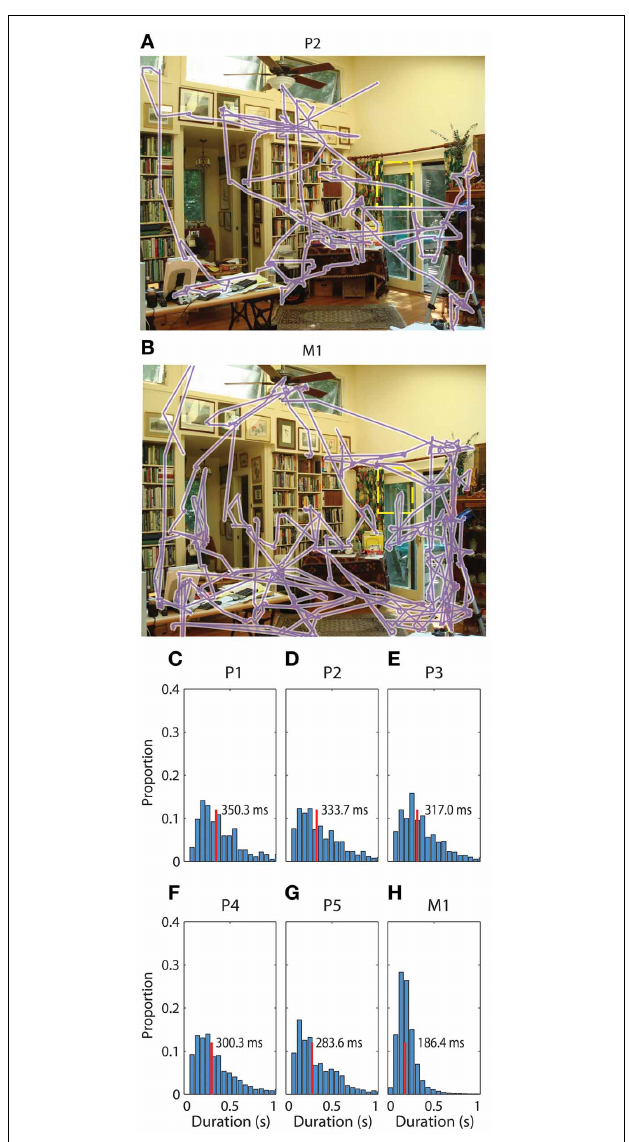
FIGURE 1 | Saccadic eye movements during visual search. (A) Gaze during one example trial from patient 2. The sequence of gaze locations is shown in purple. The target from this trial was a wind chime, which has been outlined with a yellow dashed rectangle for visibility in this figure. The patient spent the full 45s searching for the target. (B) Gaze during the same trial viewed by a macaque. Conventions are as in (A) , and the macaque also did not find the target on this trial. (C–H) Normalized histogram of fixation durations during the search task for each of the six participants in the main task, respectively. Median search times are listed and indicated with a vertical red